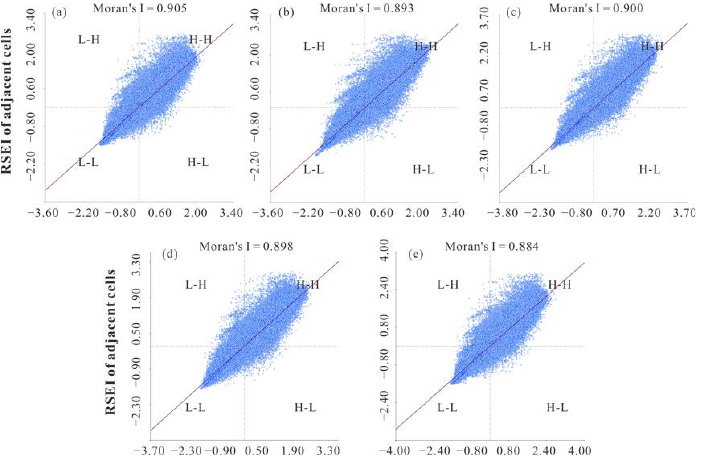
Figure 7. Moran scatter plots of the RSEI in CA (( a – e ) are 2000, 2005, 2010, 2015, and 2020, respectively).